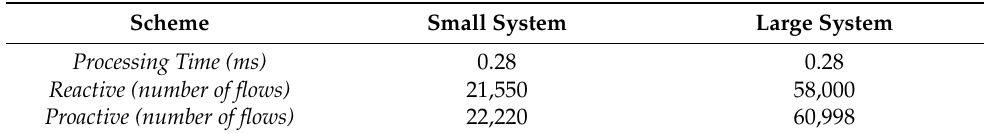
Table 4. Experimental setup.